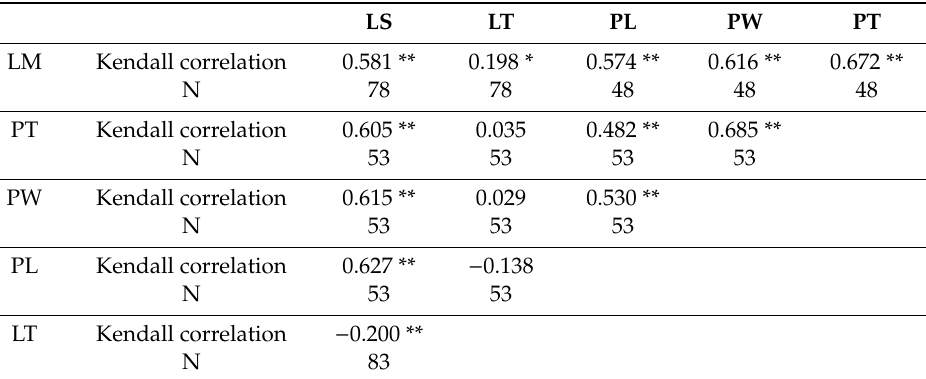
Table 2. Kendall correlation coe ffi cients among plant leaf physical properties.